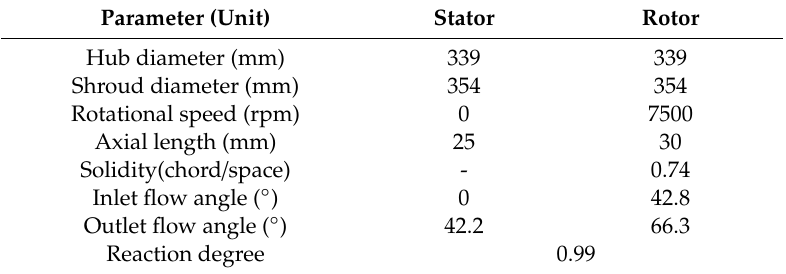
Table 4. One-dimensional thermodynamic parameters of the high-reaction design.